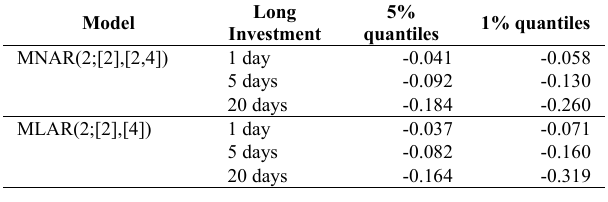
TABLE 4 T HE B EST V ALUE AT RISK M ODEL OF MLAR AND MNAR